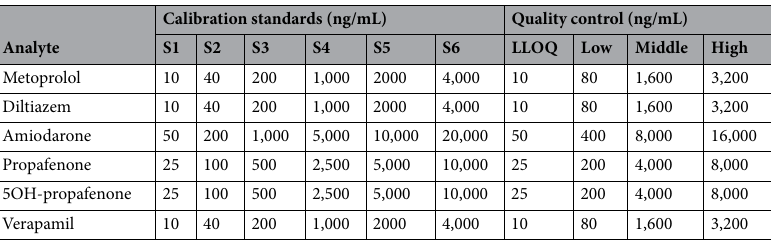
Table 1. The concentration of calibration standards and quality control